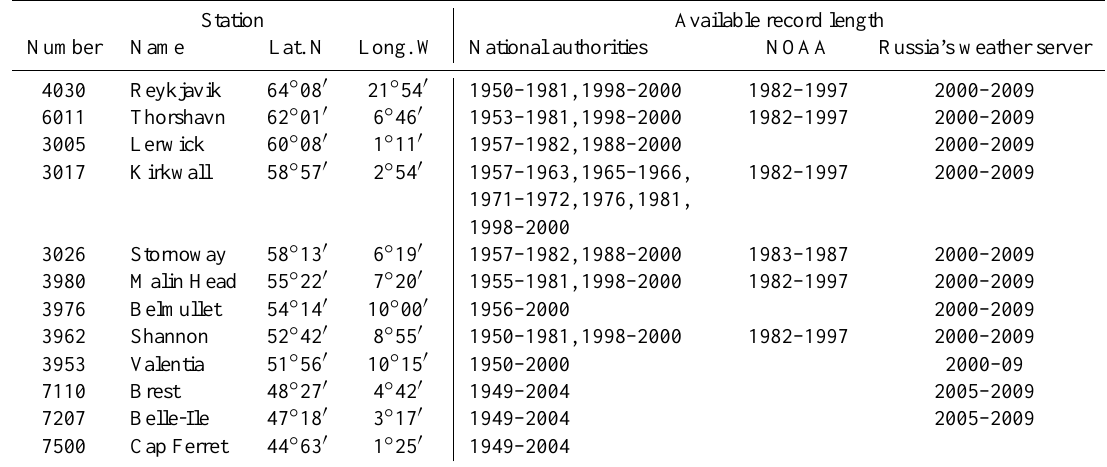
Table 1. Location of the meteorological stations considered, sources of the data and periods of observation.